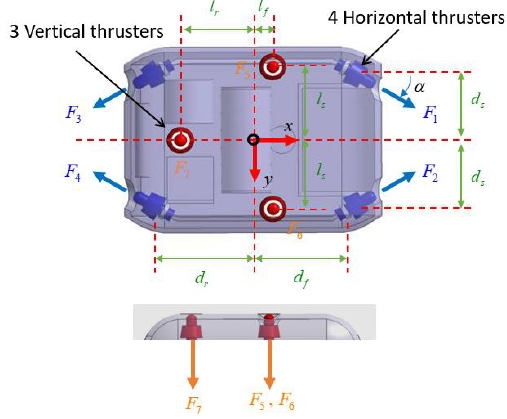
Figure 12. Layout of thrusters of the UUV.